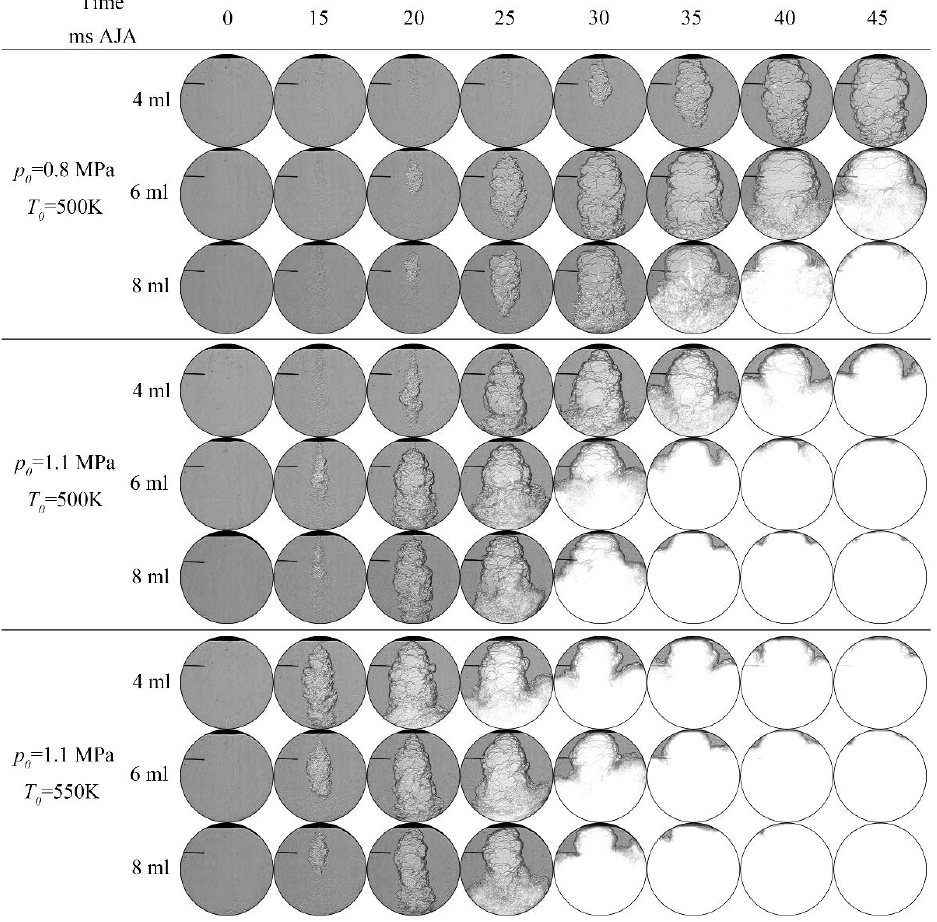
Figure 10. Shadow images of the jet ignition processes for different pre-chamber volumes under different initial thermodynamic parameters.